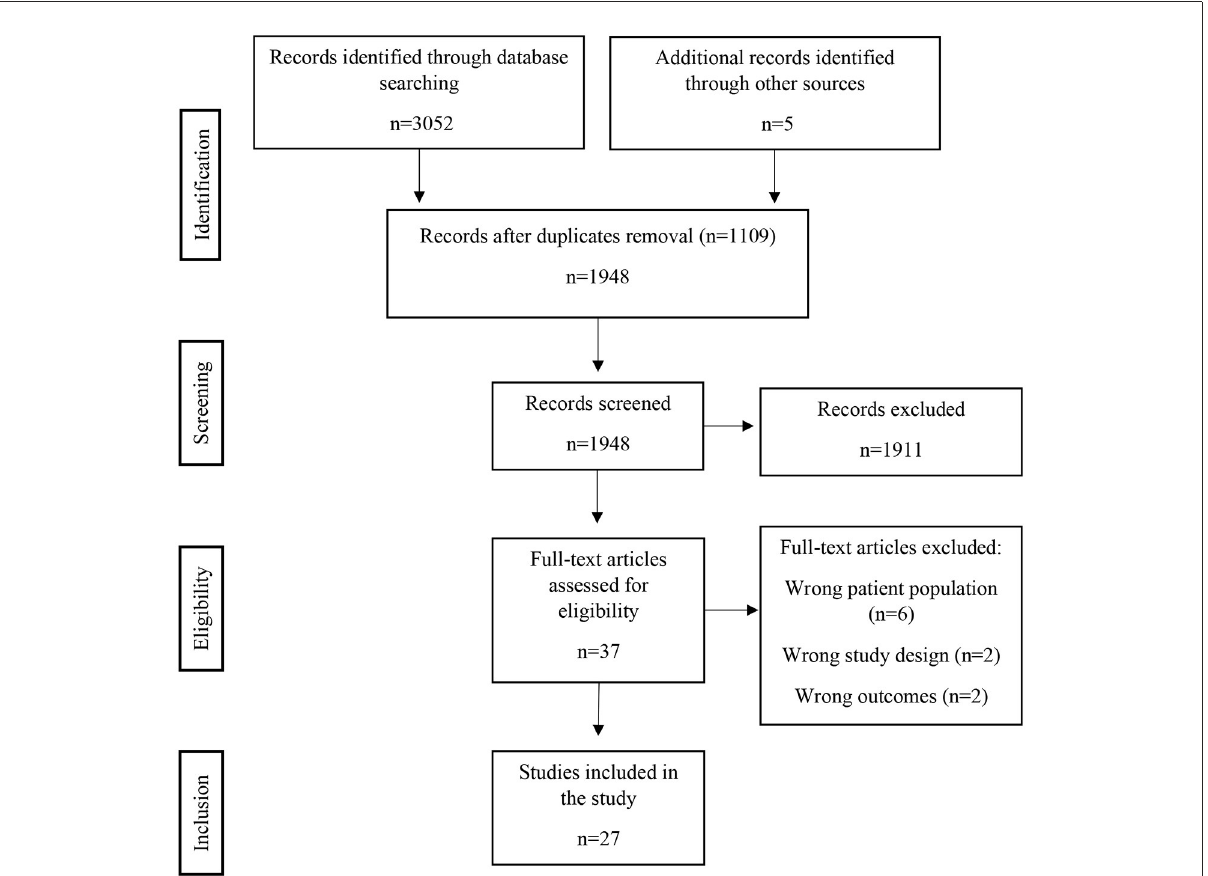
FIGURE1 PRSIMA 2020 flow diagram. There were 1,911 records excluded after screening, mostly because the subject addressed was not time perception (e.g., time in context of neuropsychological experiments not directly related to time perception, neurophysiology and time response of neurons, etc.). The full-text articles were excluded due to wrong patient population (patients with neurological diseases other than stroke – e.g., brain tumor), wrong study design (mainly focusing in other cognitive dysfunctions besides time perception or where time perception is due to another primarily cognitive dysfunction) or wrong outcomes (differences in motor tasks that occur due to time perception dysfunction but that do not translate into a specific time perception